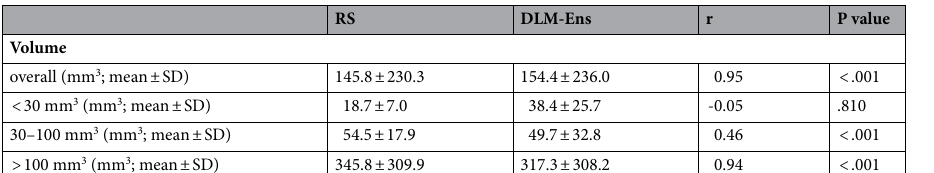
Table 3. Overall correlation between manual reference standard (RS) and DLM-Ens in the combined test cohort in relation to aneurysm volume using Pearson correlation (r).